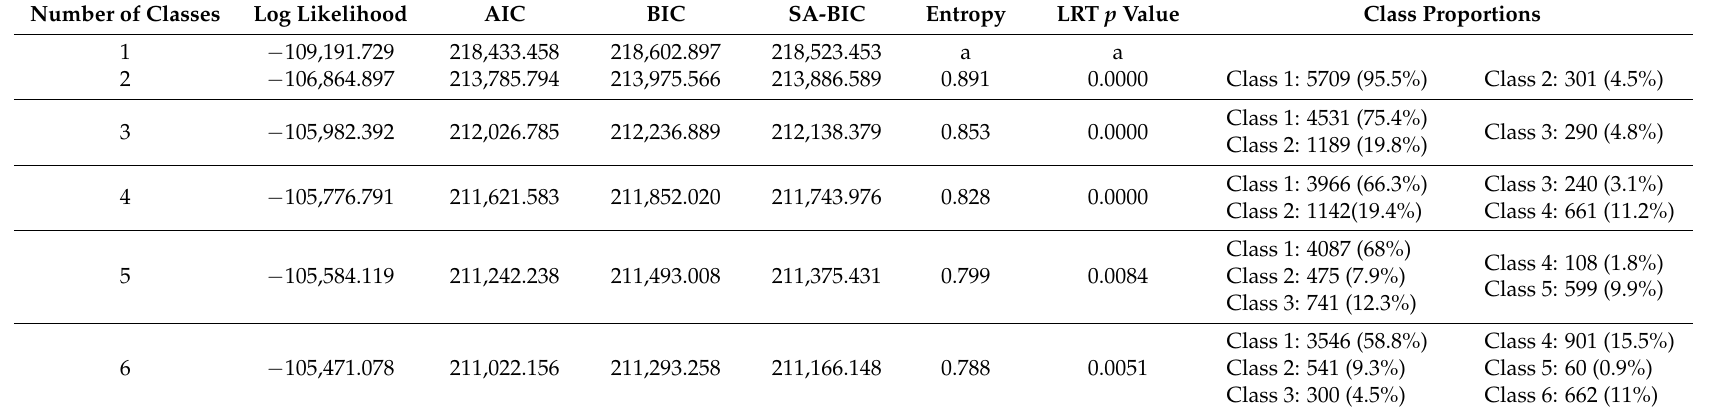
Table 1. Fit statistics for CES-D and Mobility Functional Limitation in middle-aged population